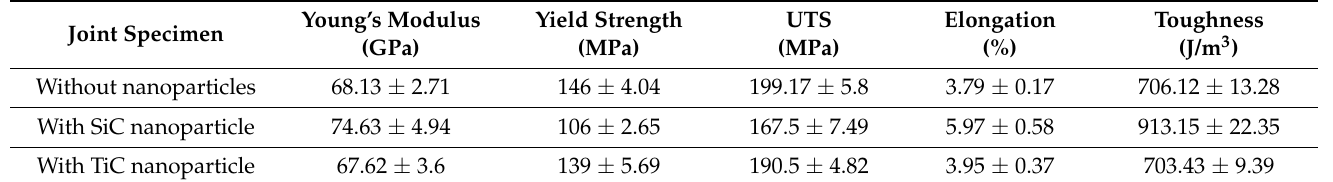
Table 3. Tensile and toughness properties of the joint without and with SiC and TiC nanoparticle reinforcement. Joint Specimen